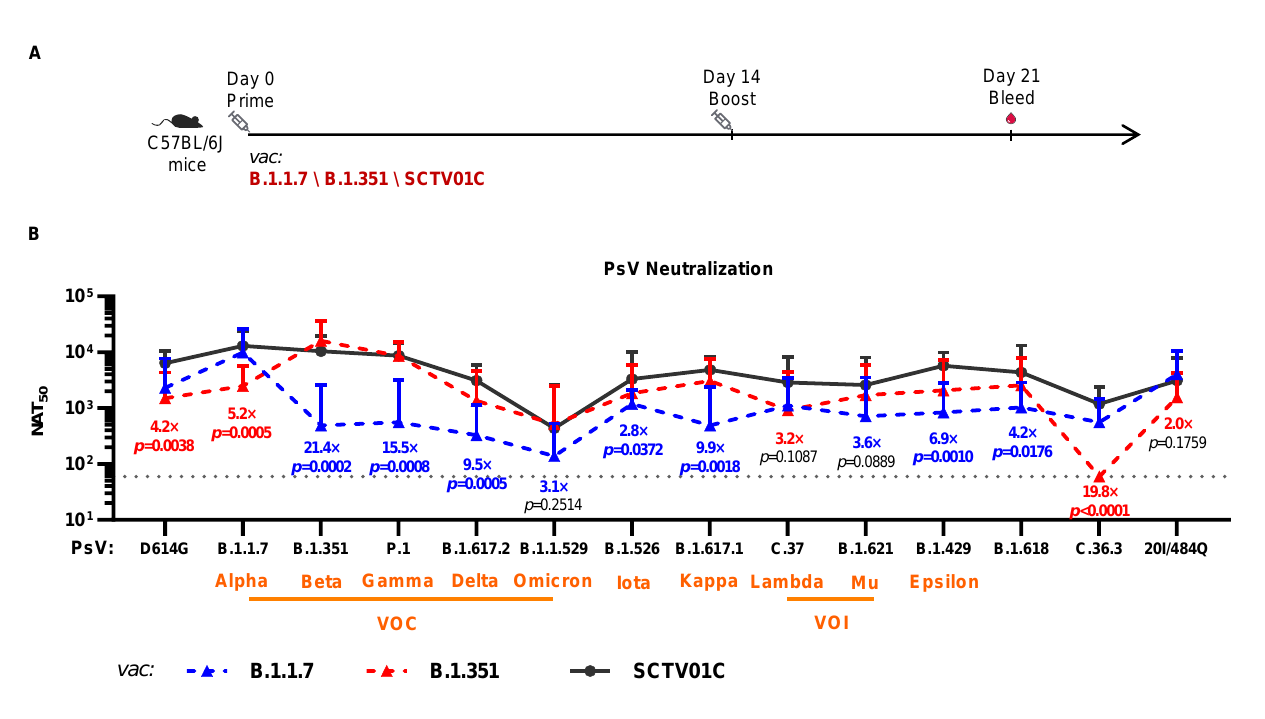
Figure 3. Cross-neutralizing activities of the B.1.1.7 monovalent, B.1.351 monovalent and SCTV01C bivalent vaccines against SARS-CoV-2 pseudovirus (PsV) based on D614G, VOCs, VOIs, VUMs and other variants. ( A ) Scheme of immunization and serum collection. C57BL/6J mice (n = 8/group) were immunized with B.1.1.7 monovalent vaccine (1 µ g/dose), B.1.351 monovalent vaccine (1 µ g/dose), or SCTV01C (1 µ g/dose for each antigen) on days 0 and 14. Inhibition of PsV infection by serially diluted mouse sera were analyzed on day 21. ( B ) Neutralizing antibody titers against each variant lineage were analyzed. The results are representative of two independent experiments. Dotted line defines the limit of detection (represented as a GMT of 60). VOC, variants of concern; VOI, variants of interest. Vac is an abbreviation for Vaccine. Bars show GMT ± SD. Data were log transformed and analyzed by Student’s t test (unpaired,